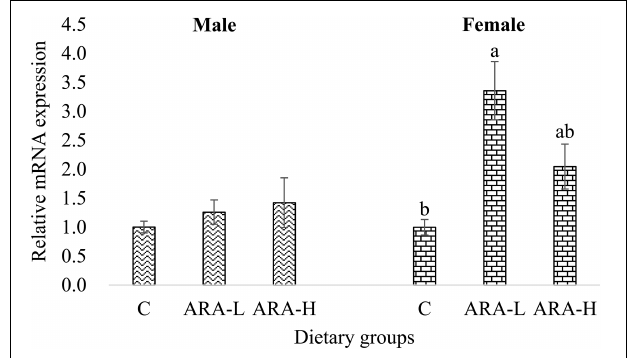
FIGURE 7 | Effects of experimental diets on mRNA expression of ch25h in the liver of Chinese tongue sole. Results are expressed as means ± standard error. Different letters above the bars denote significant ( P < 0.05) differences among dietary